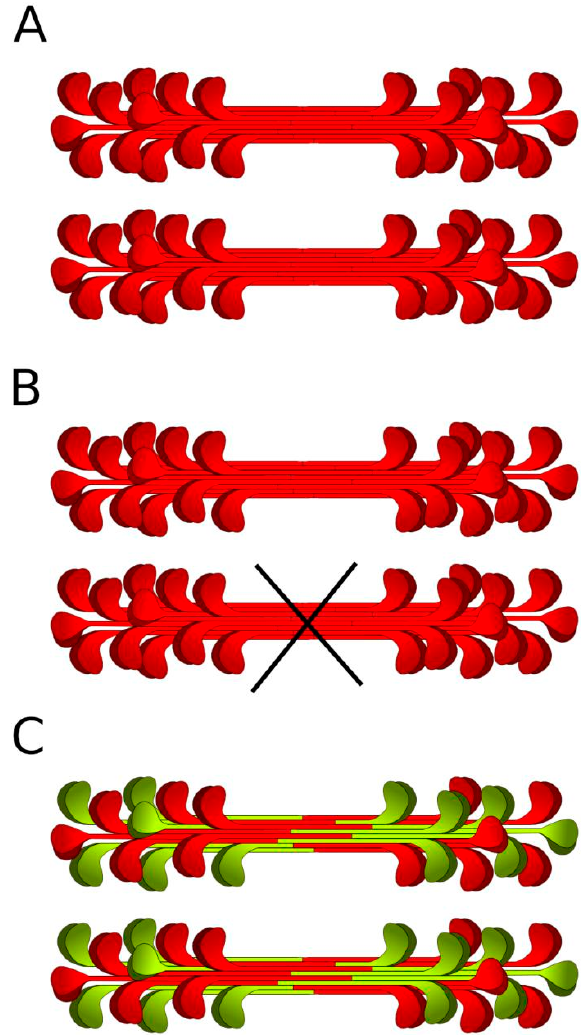
Figure 5. Schematic representation of how MYH7 participates in myosin assembly. The MYH7 gene product directly forms the myosin filament with actin-binding head. Normal functional proteins synthesized from wildtype MYH7 are colored red. Malfunctioning proteins from mutated (by dominant negative mechanism) MYH7 are colored green. ( A ) Normal formation of myosin filaments—synthesis of normal functional proteins from both copies of the MYH7 gene ( B ) Haploinsufficiency—synthesis of normal functional proteins from only one copy of the gene, the total amount of filaments decreases by half, though remaining myosin is all normal. ( C ) Dominant negative mechanism—synthesis of the proteins from both copies of MYH7 , half proteins are misfolded and malfunctioning, and all filaments contain malfunctioning proteins.